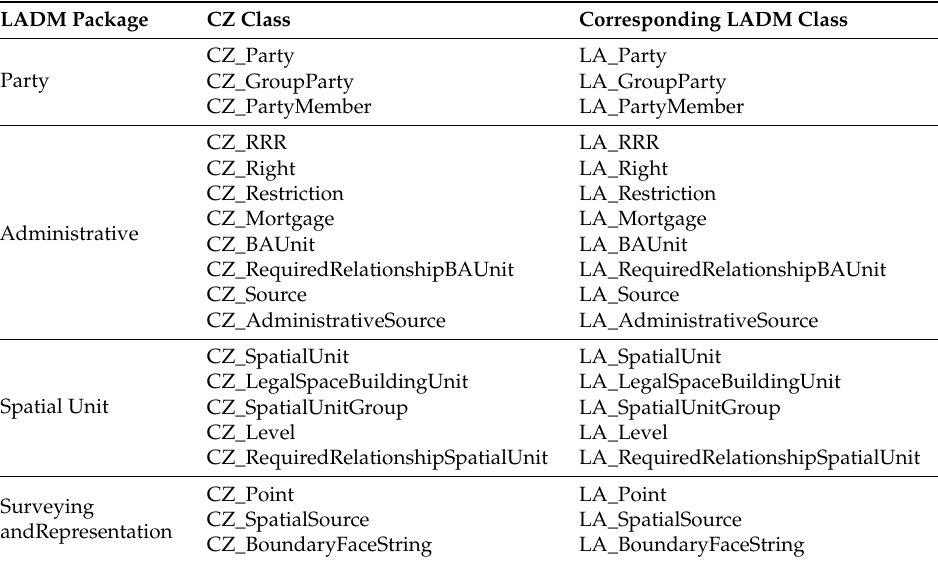
Table 1. The proposed CZ classes for the Czech cadastral profile and the corresponding LADM classes. The CZ classes with their attributes are illustrated in Figures 8 and 9.